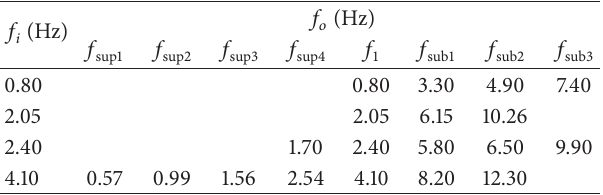
Table 3: Experiment output